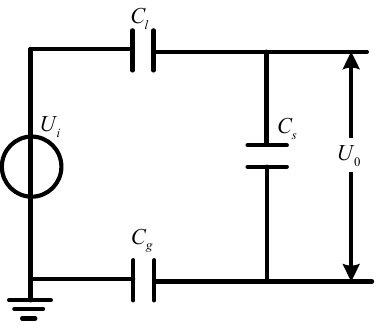
Figure 2. Equivalent circuit model of non-intrusive and ground-free voltage measurement. The voltage division ratio is